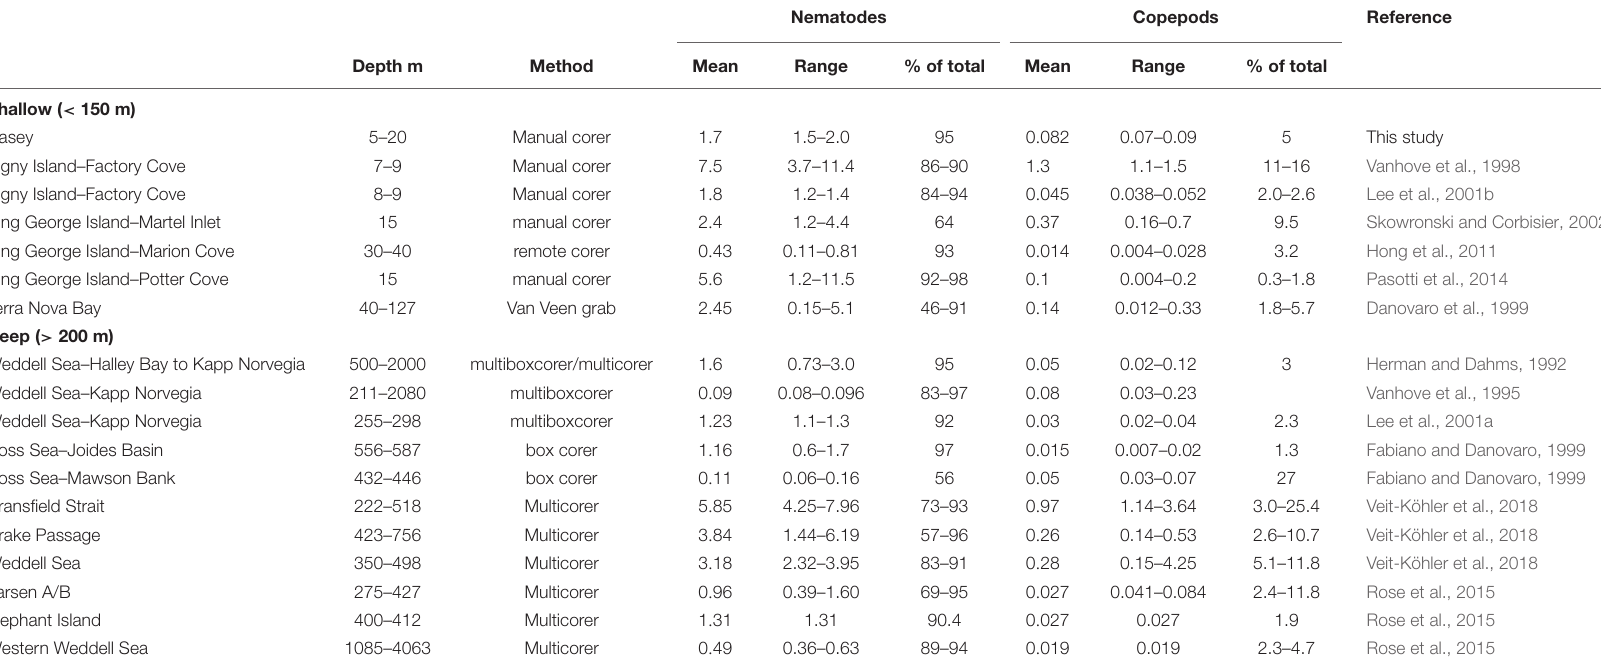
TABLE 9 | Mean abundance ( × 10 6 ) and range of nematodes and copepods in Antarctic marine sediments.